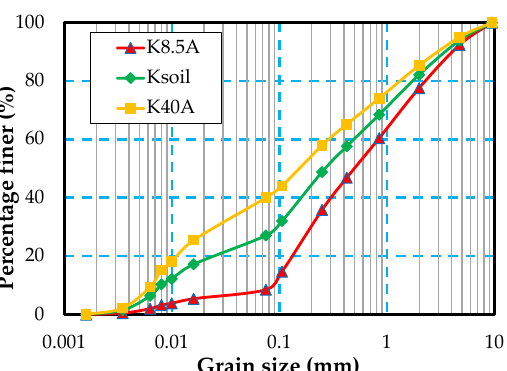
Figure 2. Grain size distribution of test samples in this study, according to [27].